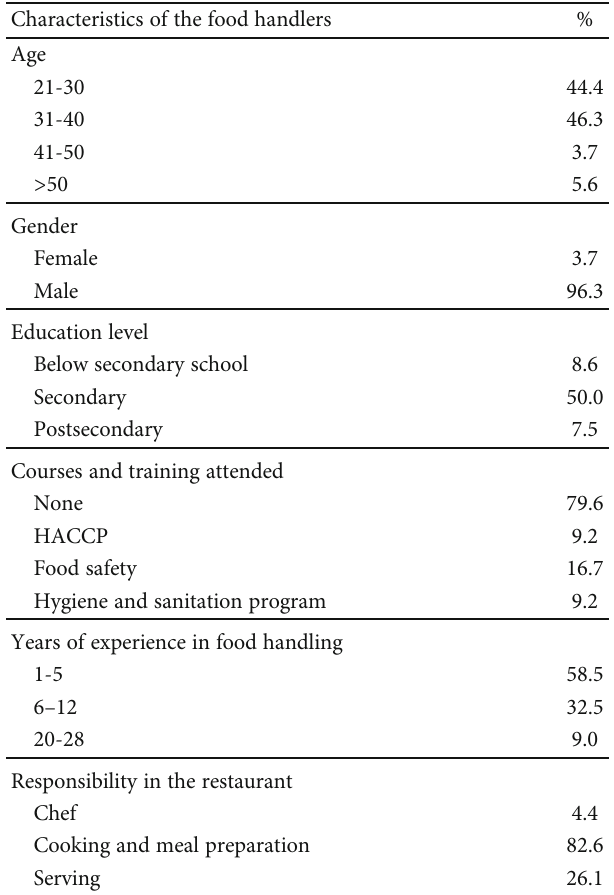
Table 1: Personal information of the food handlers including age, gender, educational level, and experience ( n = 54 ).